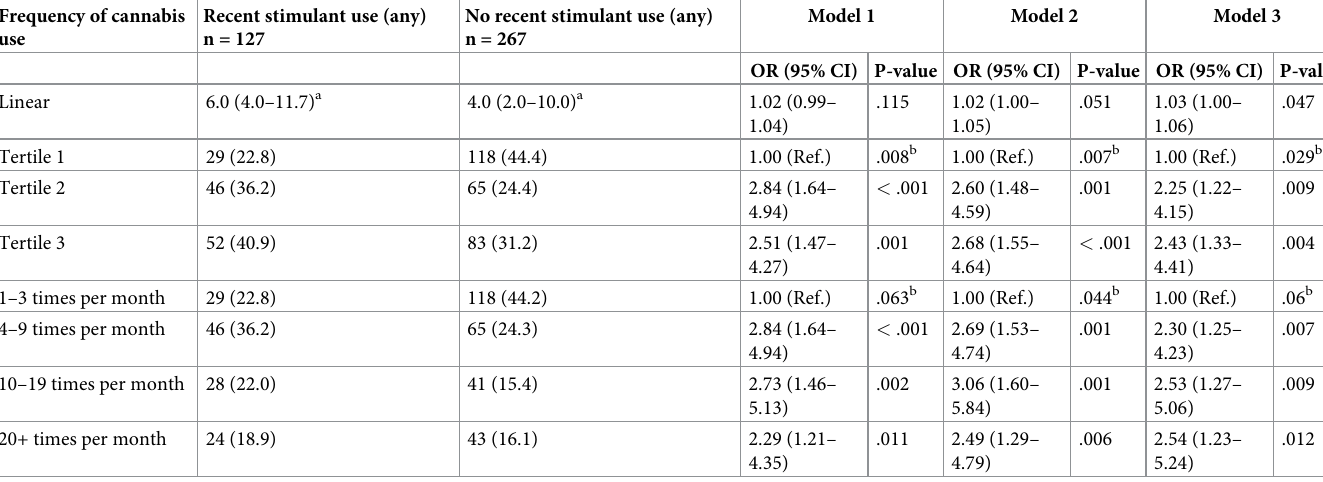
Table 3. Odds ratios for the associations between frequency of cannabis use and recent stimulant use among subjects who had used cannabis within the last 30 days. Frequency of cannabis